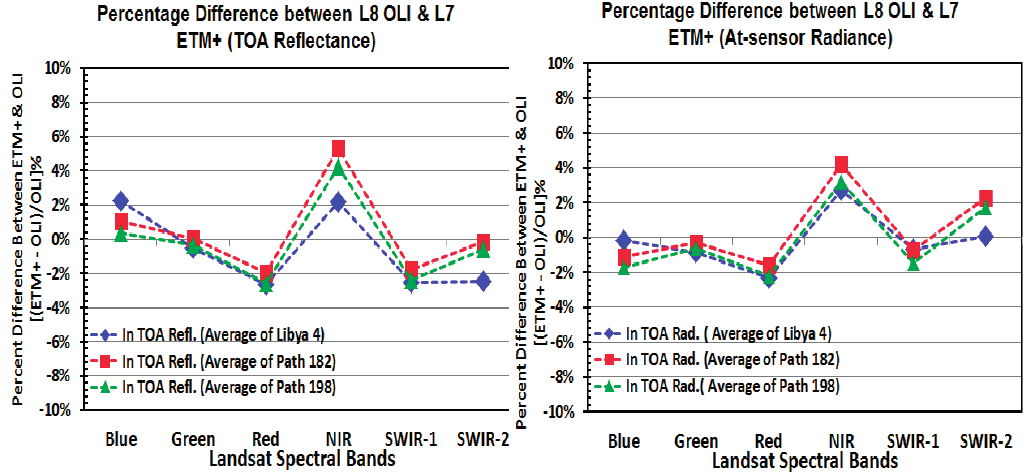
Figure 9. Summarized plot of ETM+ and OLI cross-calibration results.